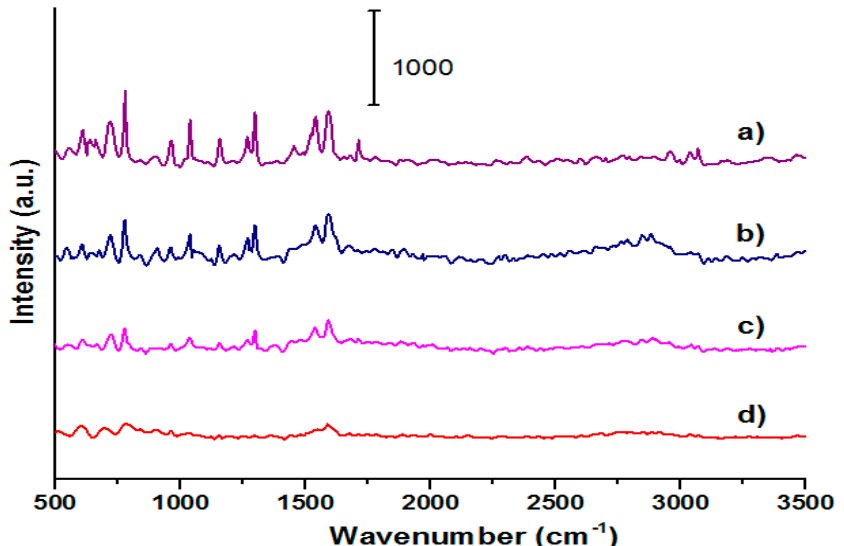
Figure 7. Raman spectra of thiophanate methyl collected on AuNSps coated glass substrate at di ff erent concentrations of thiophanate methyl: ( a ) 30 µ M, ( b ) 23 µ M, ( c ) 17 µ M and ( d ) 11 µ